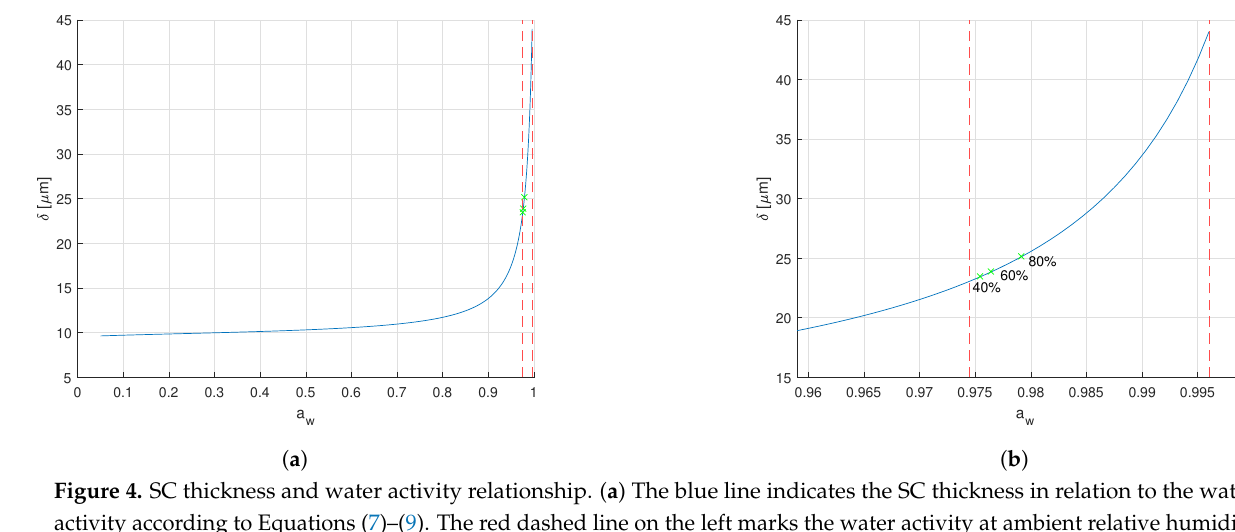
Figure 3. Comparison of electrode capacitance for constant thickness (in red) and humidity-dependent stratum corneum thickness (in blue). The dimensions of the skin are for epidermis/dermis 1mm and for hypodermis 2mm. The dry SC thickness in (9), as well as the constant thickness is set to 9.55µm. ( a ) Comparison for the circular conductance electrode: The influence of the varying thickness is especially visible in the higher water activity range, where the capacitance reduces with varying thickness but increases with constant thickness. ( b ) Comparison for the interdigitated conductance electrode: The influence of the varying thickness is visible over the complete water activity range. With constant thickness, the capacitance grows exponentially over the full range, whereas with varying thickness, the capacitance increases linearly at lower water activity and decreases at high water activity. ( c ) Comparison for the interdigitated capacitive electrode: the influence of the varying thickness is visible over the complete water activity range. With constant thickness, the capacitance grows linearly over the full range, whereas with varying thickness, the capacitance first increases at lower water activity and then decreases at high water activity.